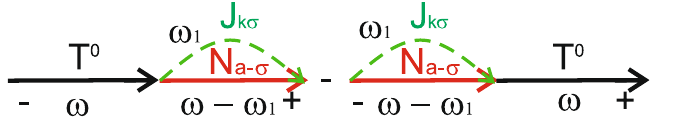
Figure 2. Diagrams contributing to the tunneling current through the T